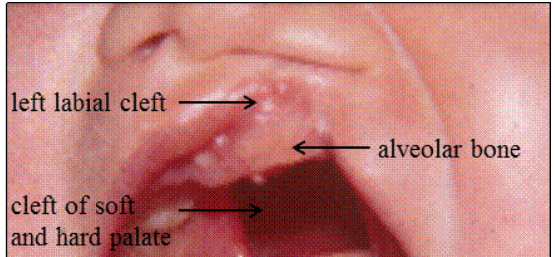
Figure 1. Example of a discontinuous cleft of the lip and/or palate (CLP) with left labial cleft associated with a cleft of the soft and hard palate. Note the presence of alveolar bone.